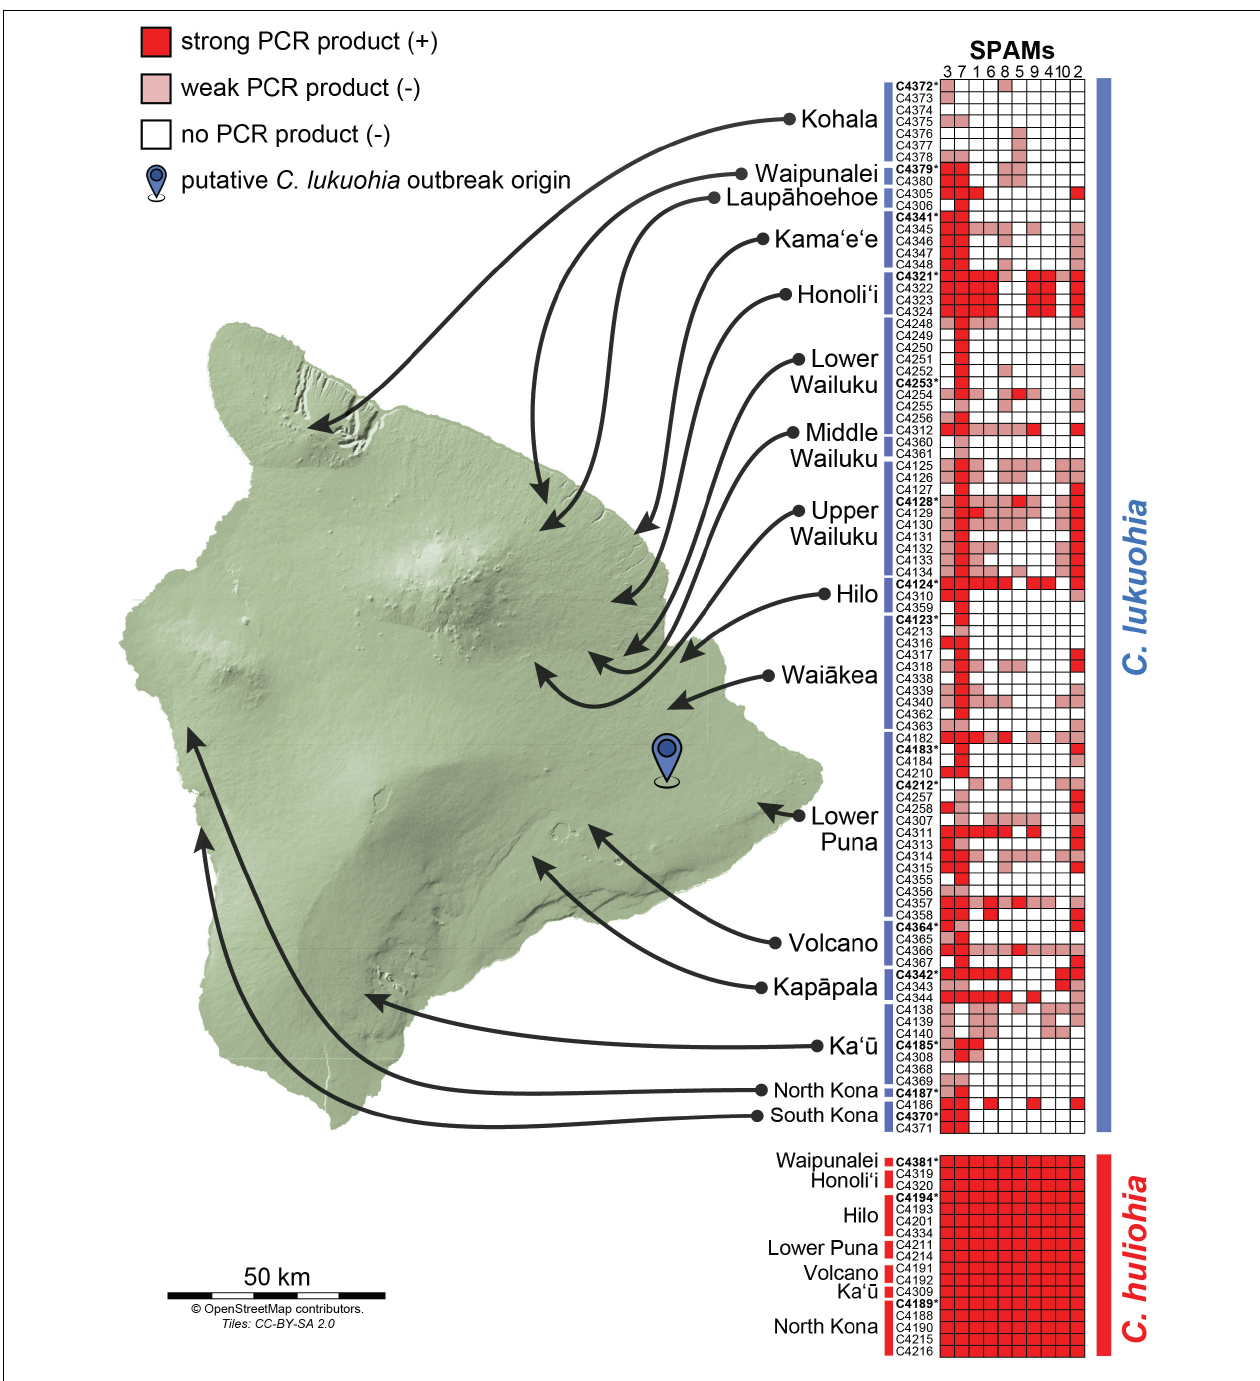
FIGURE 4 | Results of PCR surveys for the 10 SPAM elements among 89 isolates of C. lukuohia and 17 isolates of C. huliohia across Hawai‘i Island using the primers in Table 2 . Dark red boxes represent strong PCR bands (positive), faint red boxes represent weak or very weak PCR bands (interpreted as negative), and white boxes represent the absence of PCR bands (negative). Isolates for which genomes were sequenced in this study are in bold and followed by asterisks.